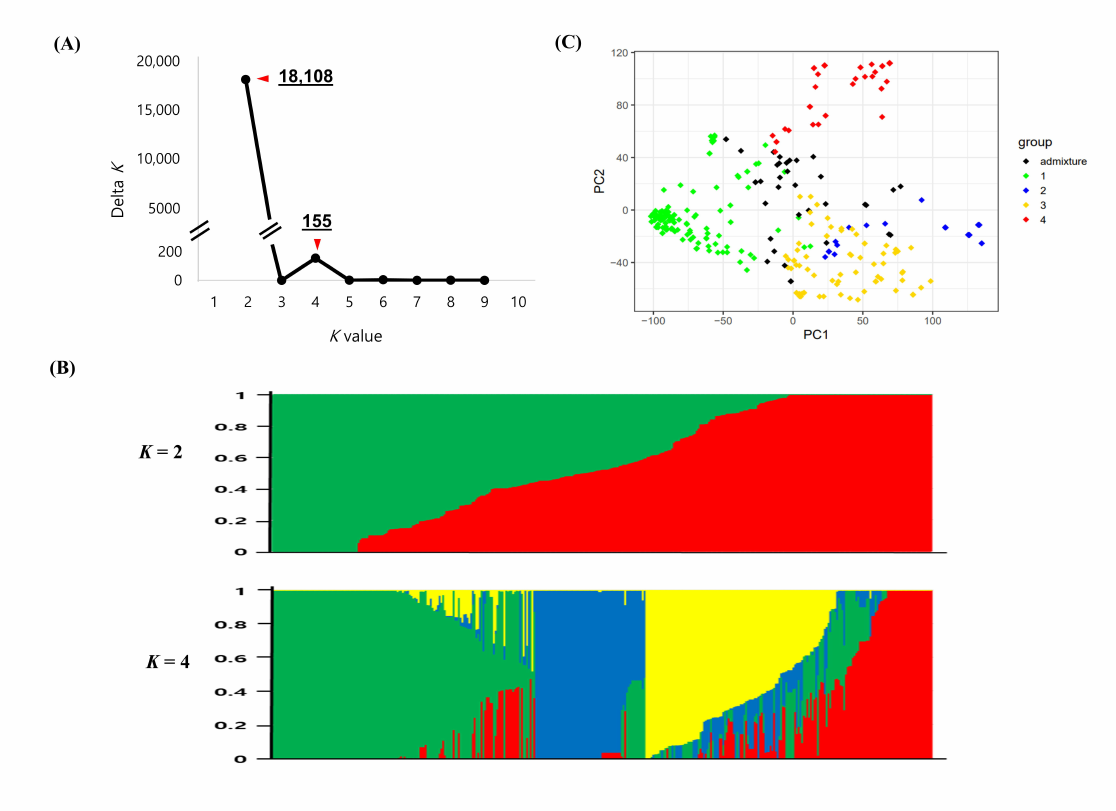
Figure 1. Population structure and principal component analysis (PCA) of the global cowpea accessions. ( A ) Delta K ( ∆ K ) plot calculated from K = 2 to K = 9. ( B ) Population structure classification of the 376 global cowpea accessions using membership probability (Q-values). Each box plot within the di ff erent colored segments represents a di ff erent population. ( C ) PCA scatter plot of the 376 accessions along the PC1 and PC2 axes. The colors of the scatter plot are the same as those in the structure box